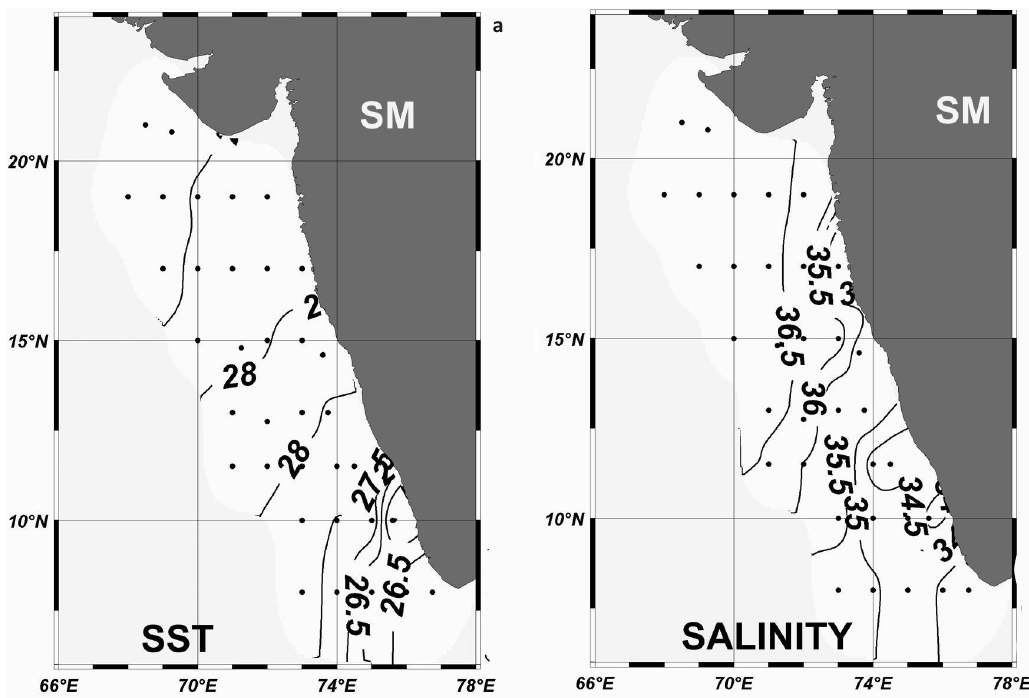
Figure 2. Spatial distribution of (a) surface temperature ( 0 C) and (b) surface salinity in Arabian Sea during the summer monsoon.